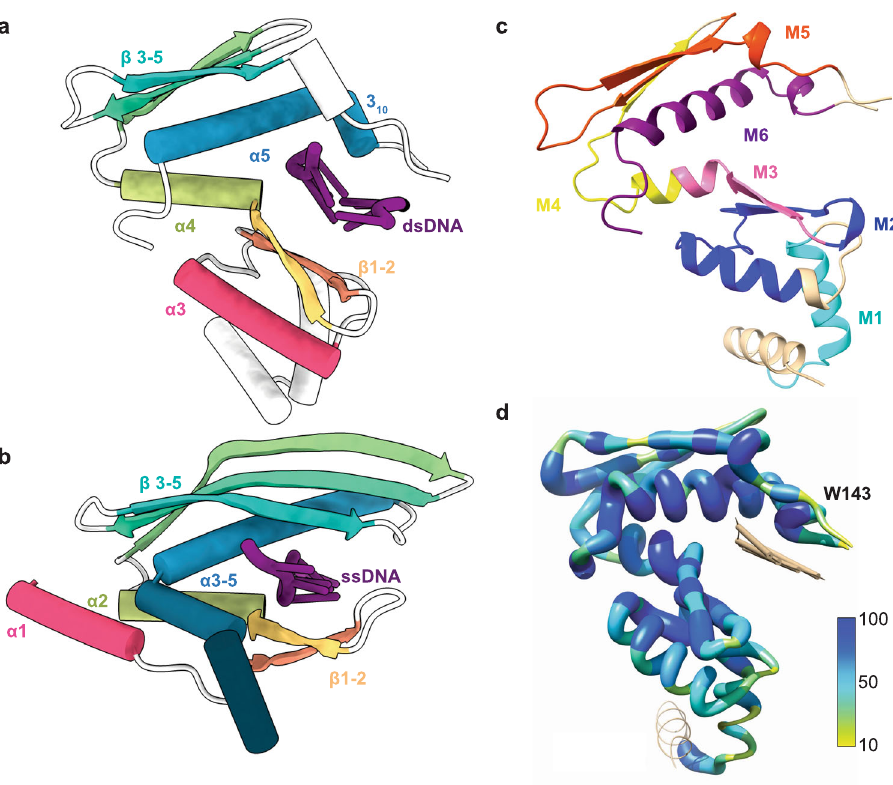
Fig. 3 | Conserved annealase structural motifs . Cartoon models comparing the secondary structures of Red β 177 ( a ) and Rad52 (5XRZ) ( b ). Color denotes conserved secondary structures between the proteins, while white represents regions that are not conserved between the structures and DNA is shown in purple. c The ribbon